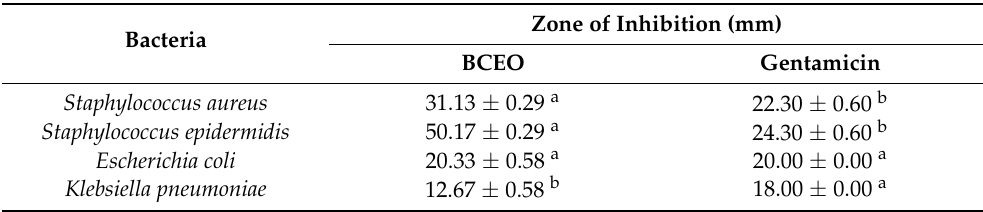
Table 2. Antibacterial activity of BCEO and standard antibiotic (gentamicin) expressed by the diameter of the inhibition zone (mm).